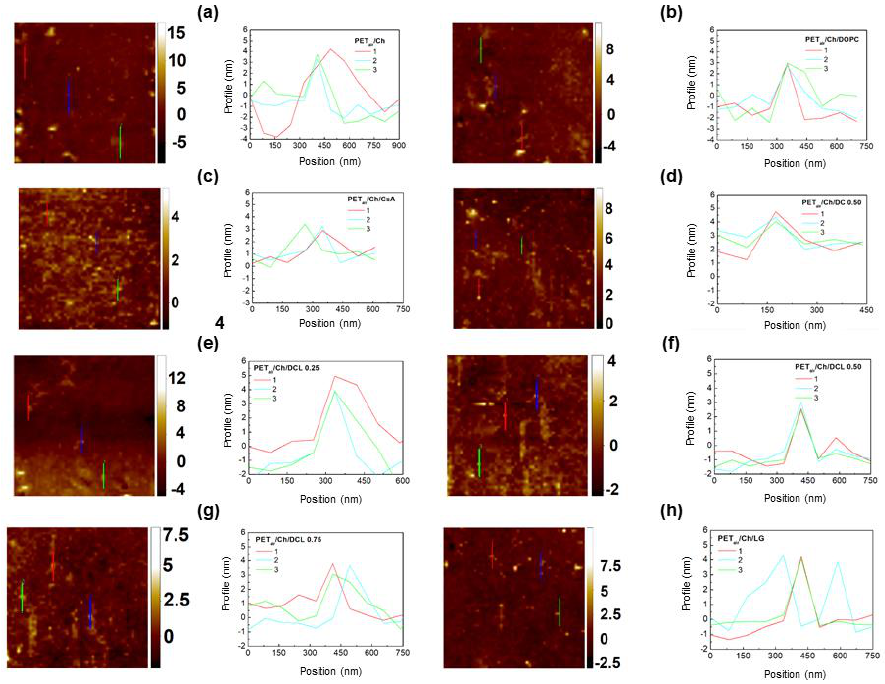
Figure 7. AFM zoomed micrographs and profiles obtained for: PET air /Ch ( a ), PET air /Ch/DOPC ( b ), PET air /Ch/CsA ( c ), PET air /Ch/DOPC-CsA 0.50 ( d ), PET air /Ch/DOPC-CsA-LG 0.25 ( e ), PET air /Ch/DOPC-CsA-LG 0.50 ( f ), PET air /Ch/DOPC-CsA-LG 0.75 ( g ), PET air /Ch/LG ( h ). Z scale: nm